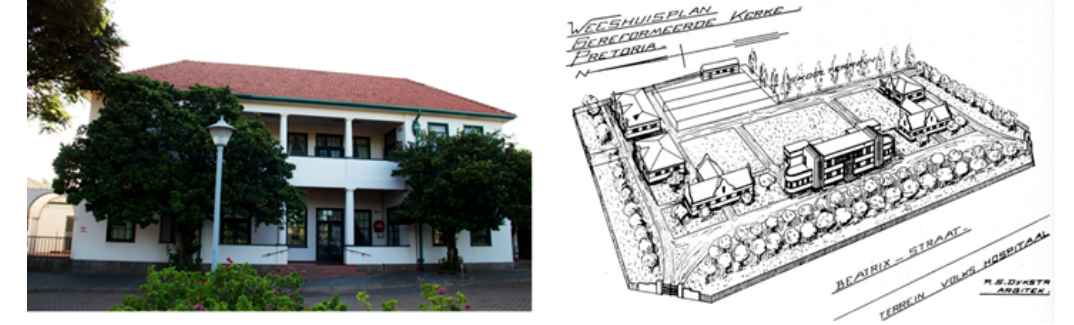
Figure 6. The former Louis Botha children’s home and the design for the President Kruger Child- ren’s Home, both in Pretoria (Source: author (left); Gereformeerde Kerk Almanak , 1934, public domain